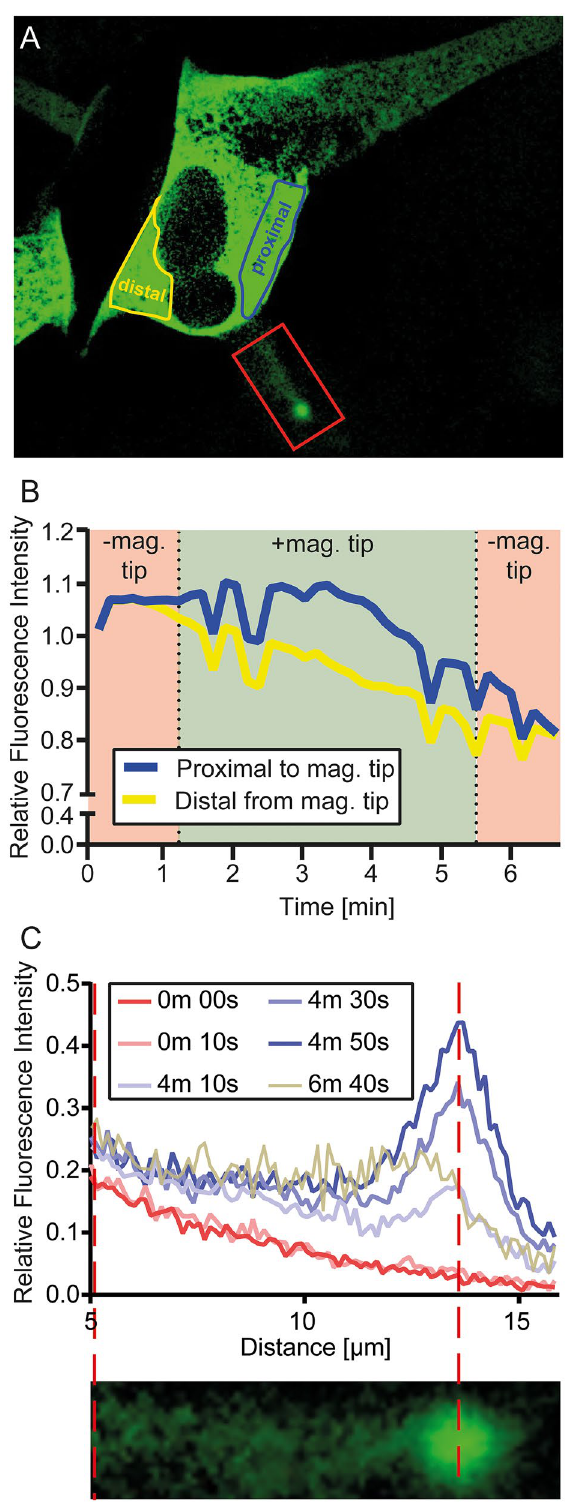
Figure 5. Analysis of the magnetic manipulation of HTL-MNP-bound HT-SOS1cat-Clover in SH-SY5Y cells. ( A ) An image of a SH-SY5Y cell expressing HT-SOS1cat-Clover injected with HTL-MNPs (MNP fluorescence not shown). The ROI of the cell body distal from the magnetic tip is indicated in yellow. The ROI of the cell body proximal to the magnetic tip is indicated in the region enclosed by the blue line. ( B ) Normalized and bleaching corrected RFI of both ROIs over time. − mag. tip indicates the period from when the magnetic tip was not in the field of observation (before 1 min 10 s and after 5 min 30 s). + mag. tip indicates when the magnetic tip was in the field of observation (1 min 10 s to 5 min 30 s). The differential area of fluorescence intensities during the application of the magnetic tip (+ mag. tip) between the blue (proximal to tip) and yellow (distal to tip) curves indicates a formal redistribution of HT-SOS1cat-Clover by about 12%. ( C ) The line profile of the fiber including its tip [red ROI in ( A )] at different time points. The red broken lines indicate the position of the maximal fluorescence in the fiber´s